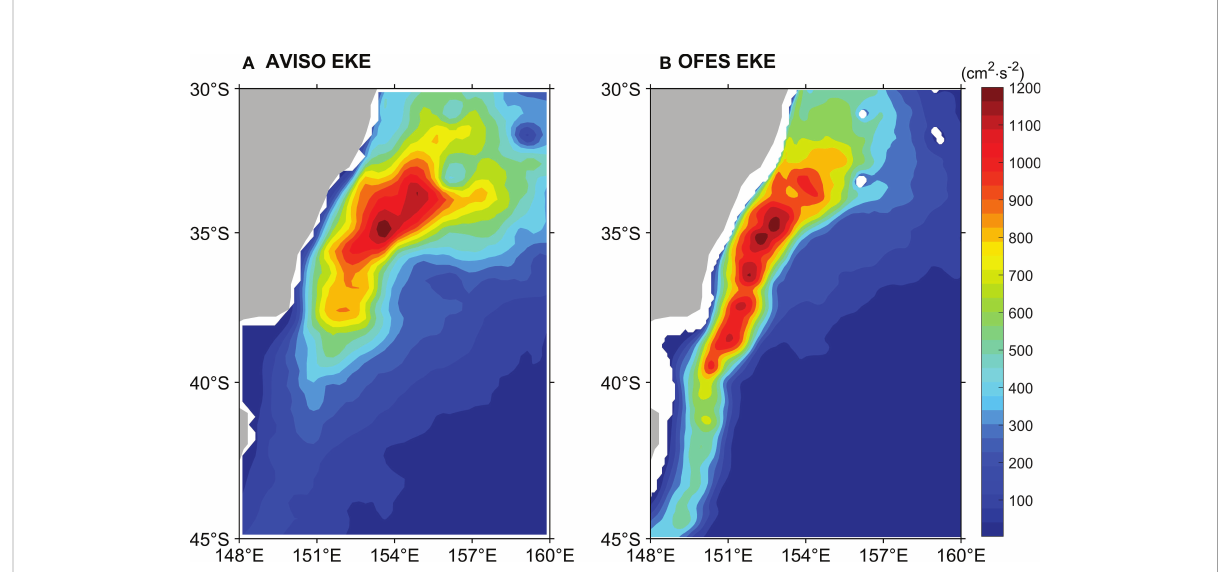
FIGURE 2 Climatological mean eddy kinetic energy (EKE, Unit: cm² s - ²) calculated from the SLA data from (A) AVISO during January 1993-December 2019 and (B) OFES (0-300m) during July 1999-October 2009. EKE is calculated from Eq.